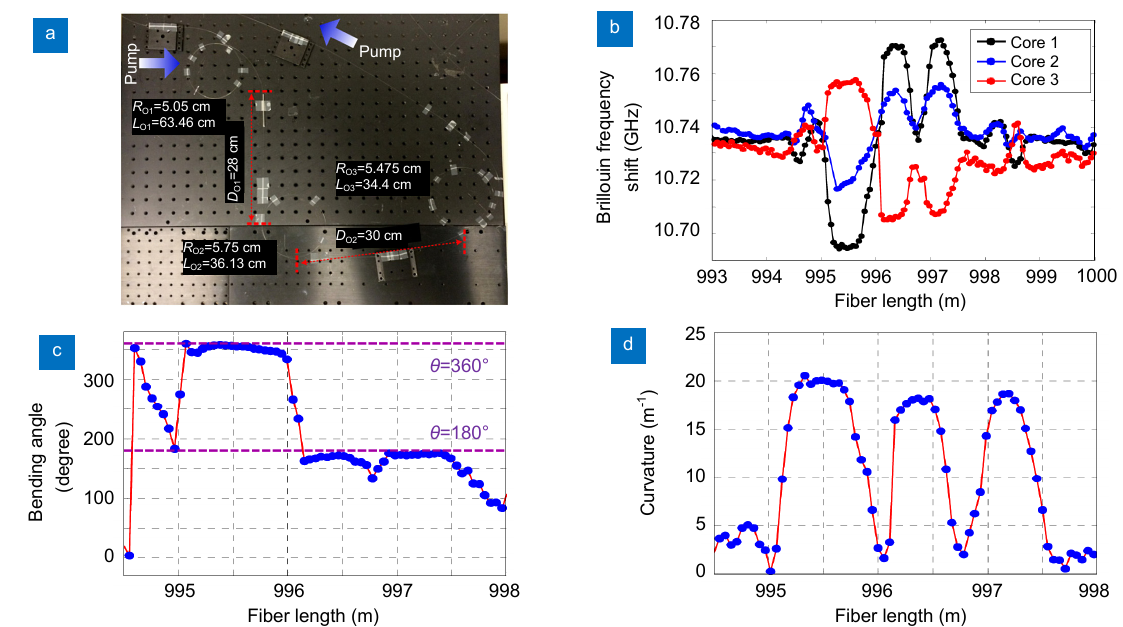
Fig. 10 | ( a ) Three O-shapes made for validating the ability of distributed curvature and shape sensing based on BOTDA in MCF. ( b ) The meas- ured BFS profiles as a function of distance along three cores around the 3 O-shape regions. ( c ) Retrieved bending angle for the 3 O-shape regions. ( d ) Retrieved curvature for the 3 O-shape regions. Figure reproduced from ref. 25 , Optical Society of